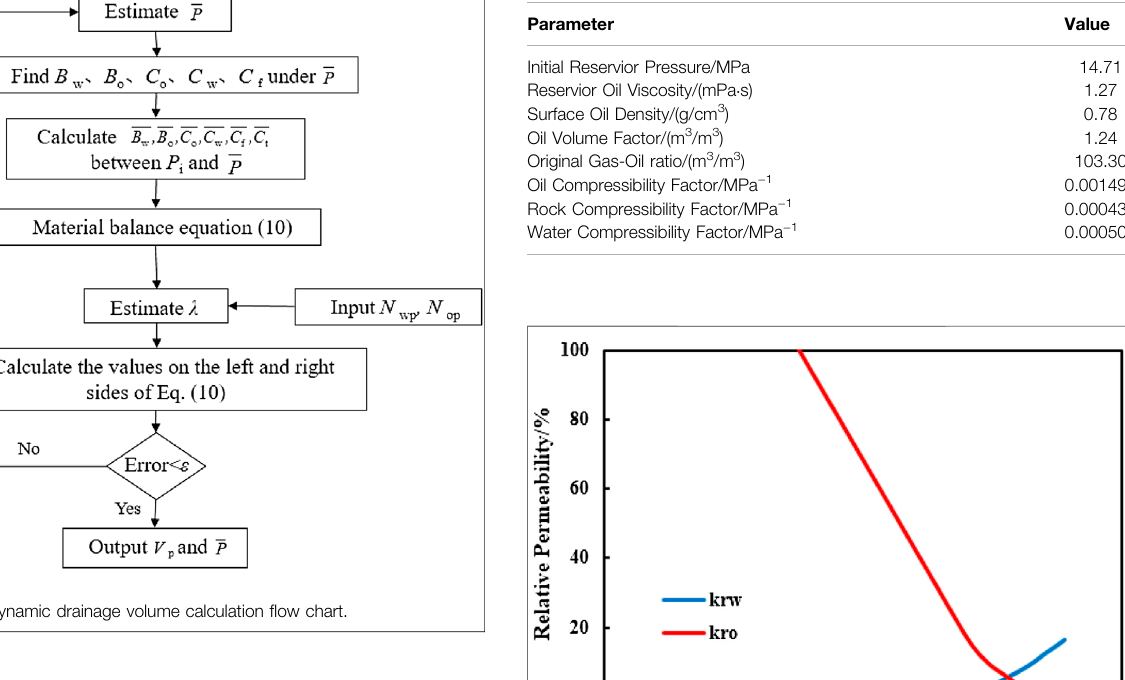
TABLE 1 | Parameters of depleted development liquid model.